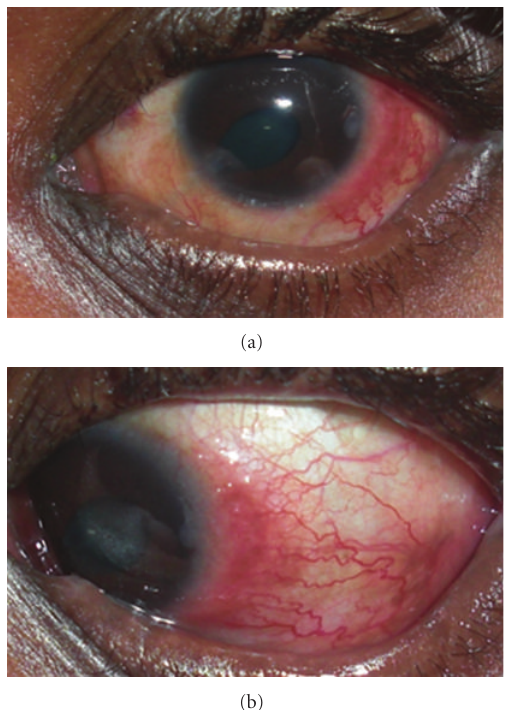
Figure 1: External photographs of the patient reported in our case. Marked temporal limbal injection and focal conjunctival elevation is